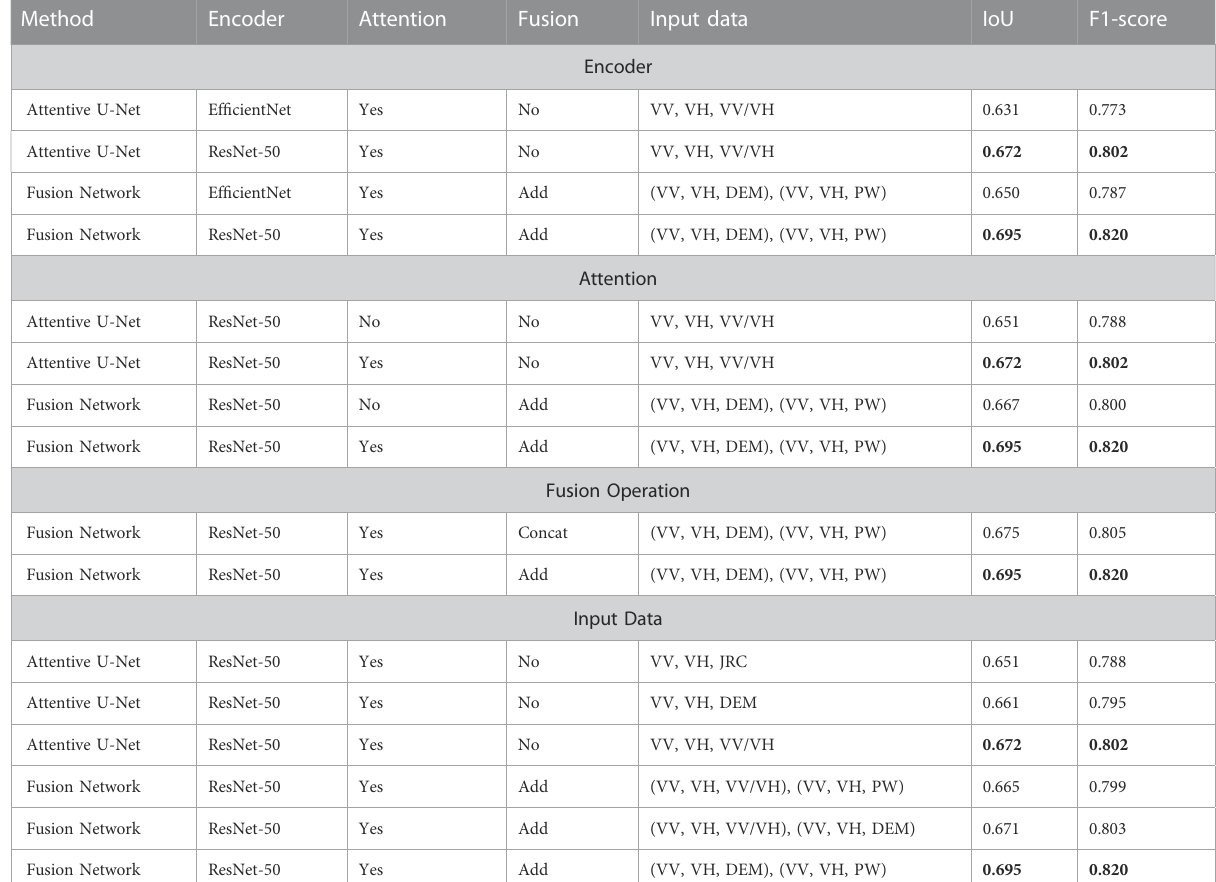
TABLE 2 Ablation Study. The comparison is made in terms of average IoU and F1 score on test dataset. The best scores are highlighted in